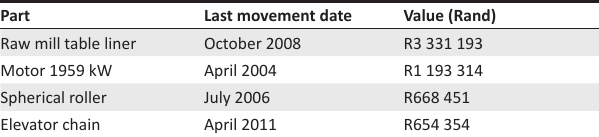
TABLE 1: Parts cost and movement history.